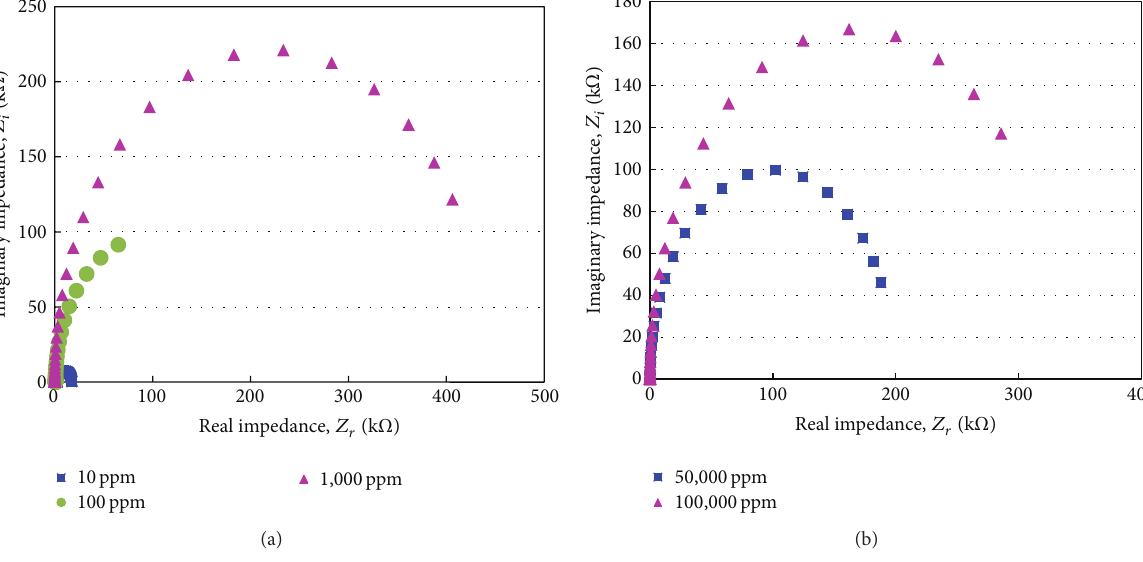
Figure 5: Effect of NaNO 2 addition on Nyquist plot obtained from AC impedance measurement in deaerated simulated cooling water at 25 ∘ C; (a) carbon steel at +400 mV (SCE) and (b) ductile cast iron at 0V